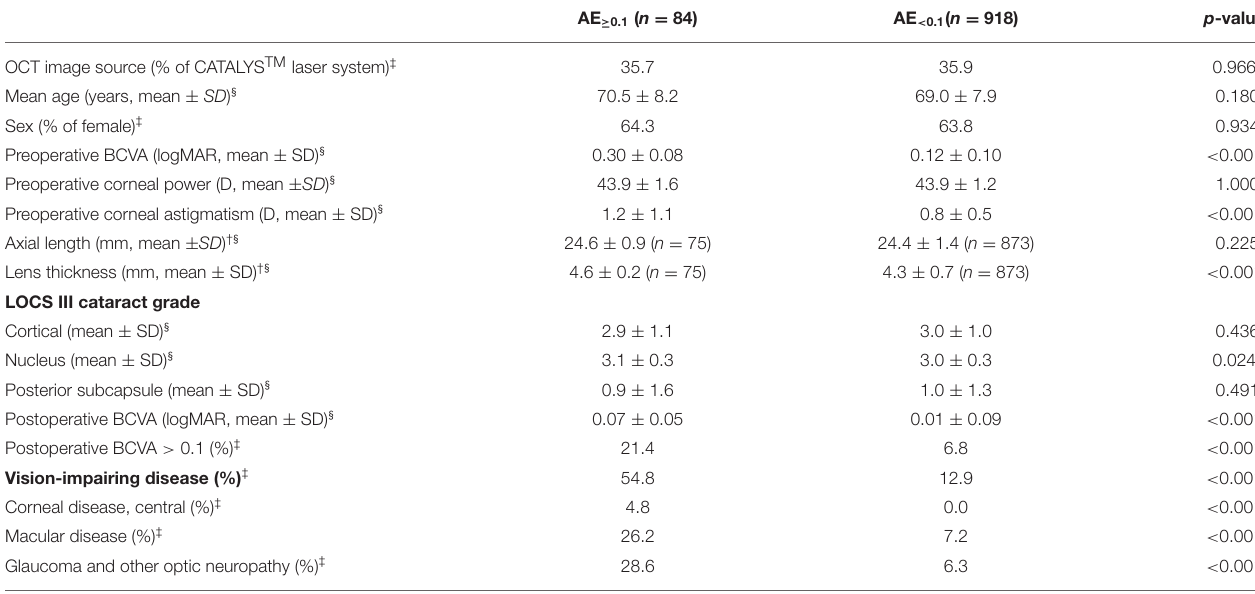
TABLE 3 | Comparison of the patients showing absolute error of BCVA of 0.1 and over (AE ≥ 0.1 ) with those showing absolute error under 0.1 (AE < 0.1 ) in the test